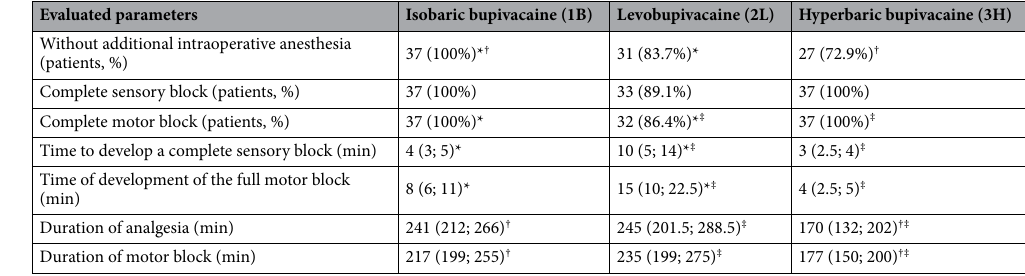
Table 2. Characteristics of spinal anesthesia in the study groups. Values are median (1Q, 3Q). Symbols: * † ‡ indicators marked with the same symbols have significant differences between each other in the horizontal line on this indicator (p <